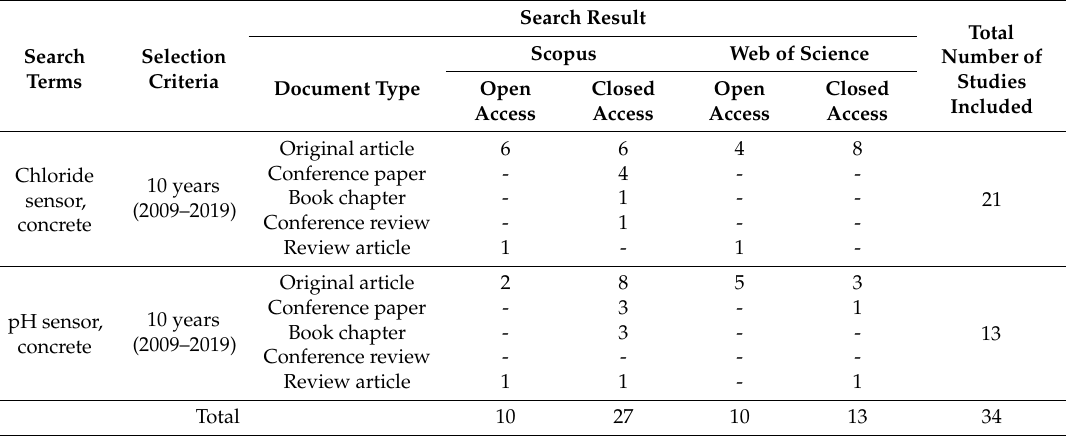
Table 1. Search details and